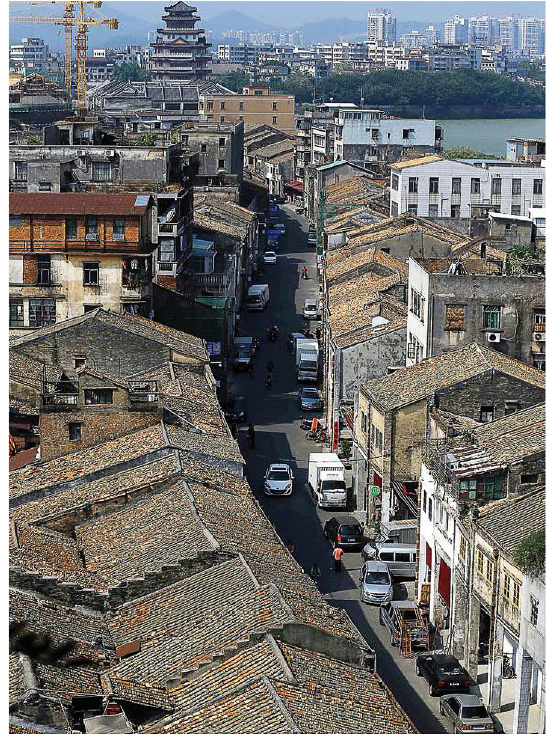
Fig. 2 Cantonese arcade houses along East Shuidong Street. (Source: An-Design Architects)